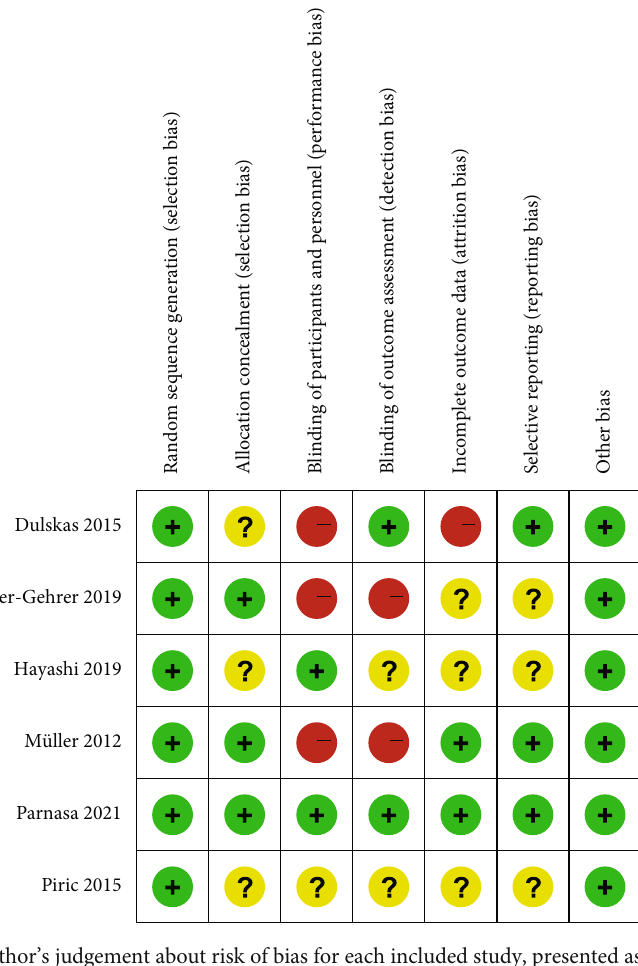
Mean difference IV, fixed, 95% CI